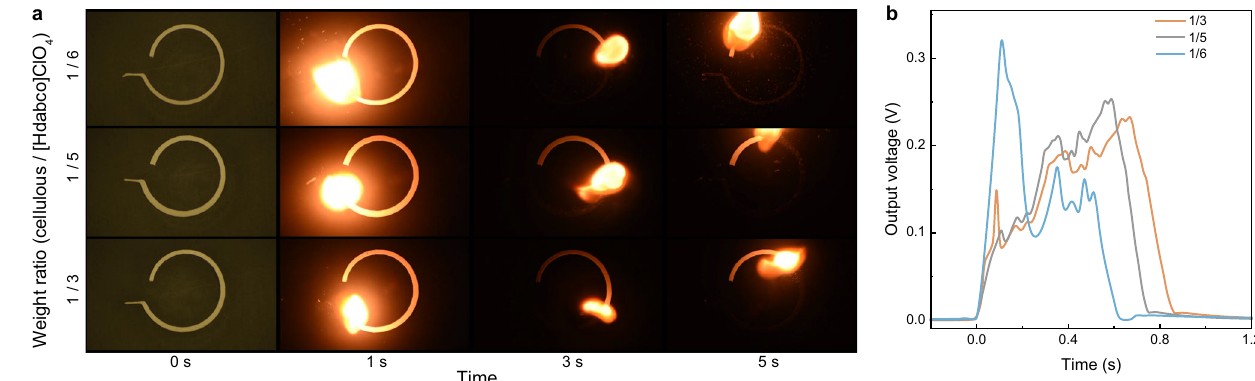
Fig. 6 | The controlofchemicalenergy release. a , Selected snapshots from the video for the decompositionof3D printed [Hdabco]ClO 4 with different weight ratios of cellulose/[Hdabco]ClO 4 . b The decomposition generated electricity from [Hdabco]ClO 4 with different weight ratios of cellulose/[Hdabco]ClO 4